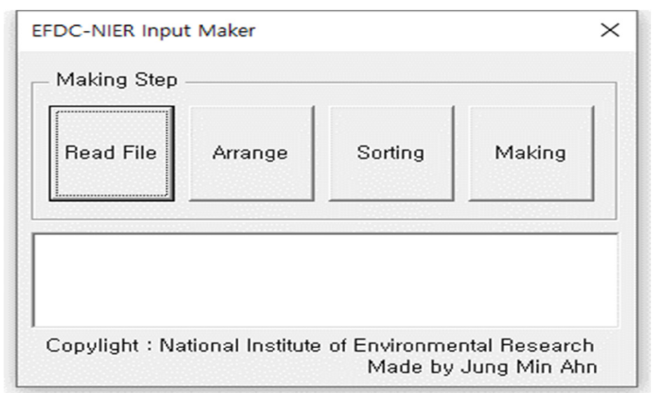
Figure 4. Automatic input data generation module for EFDC-NIER